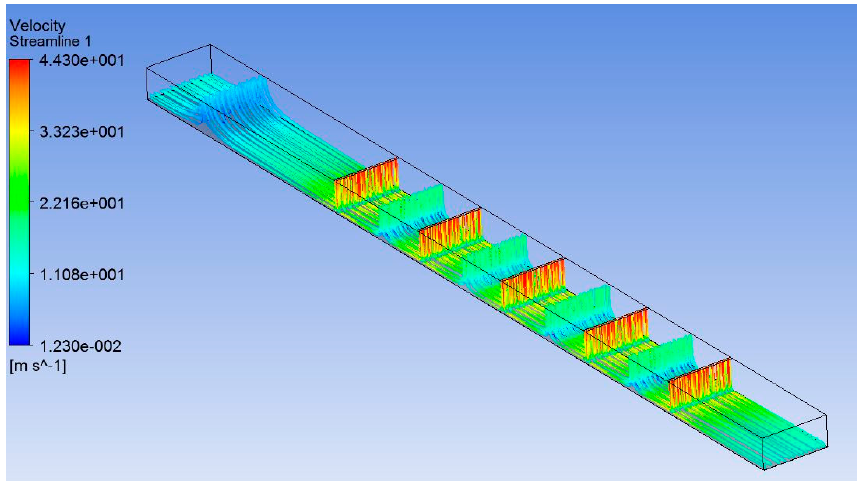
Figure 20. Streamlines in the configuration #1 with 5 slots.